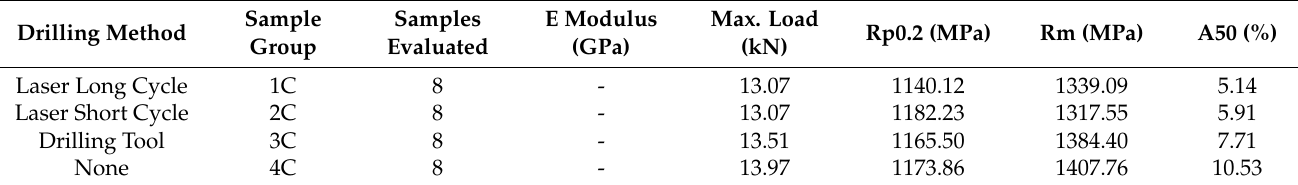
Table 8. Average values of mechanical properties—Inconel 718; material thickness 1.6 mm; tests at room